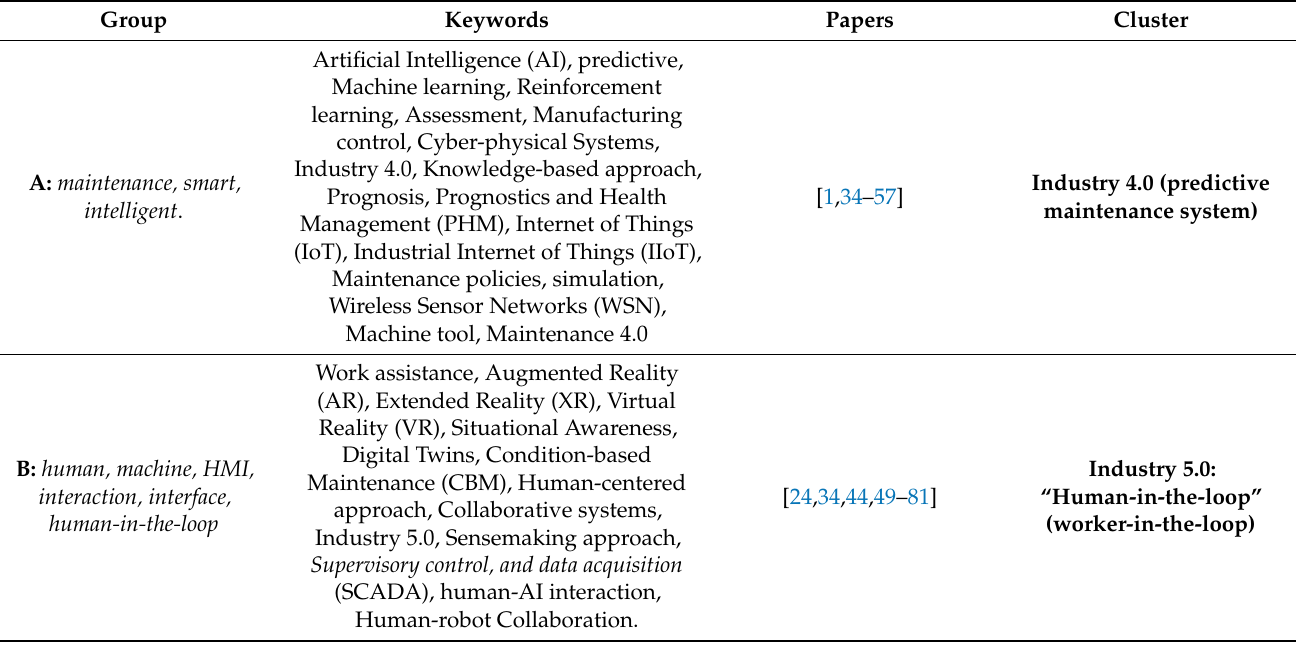
Table 4. Insights from the literature scoping